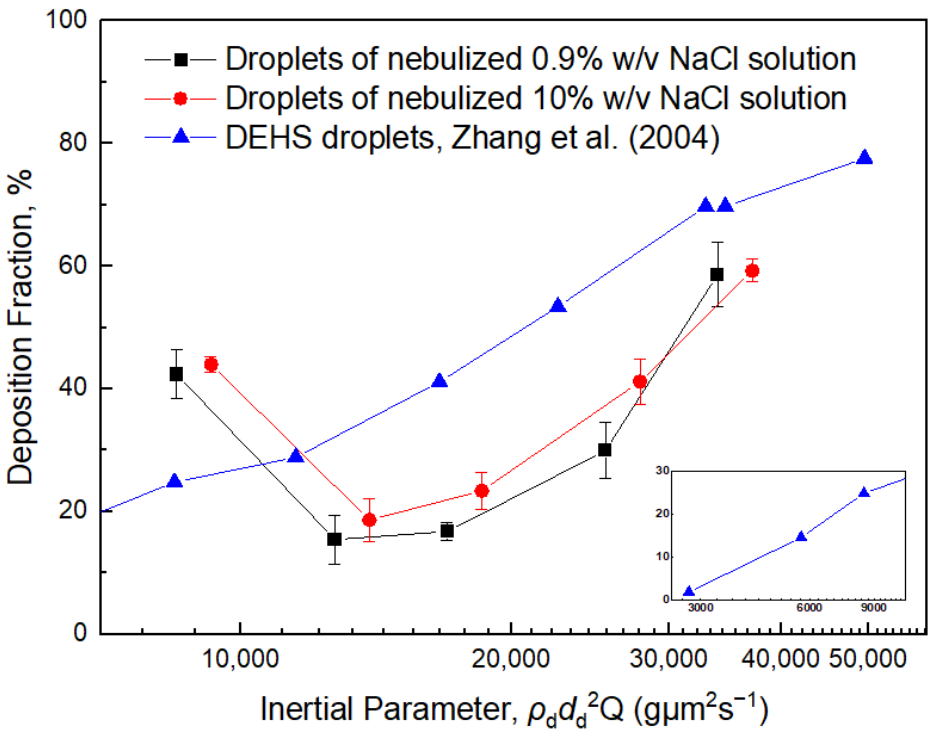
Figure 4. DF of different droplets in the idealized mouth-throat airway as a function of inertial parameter.